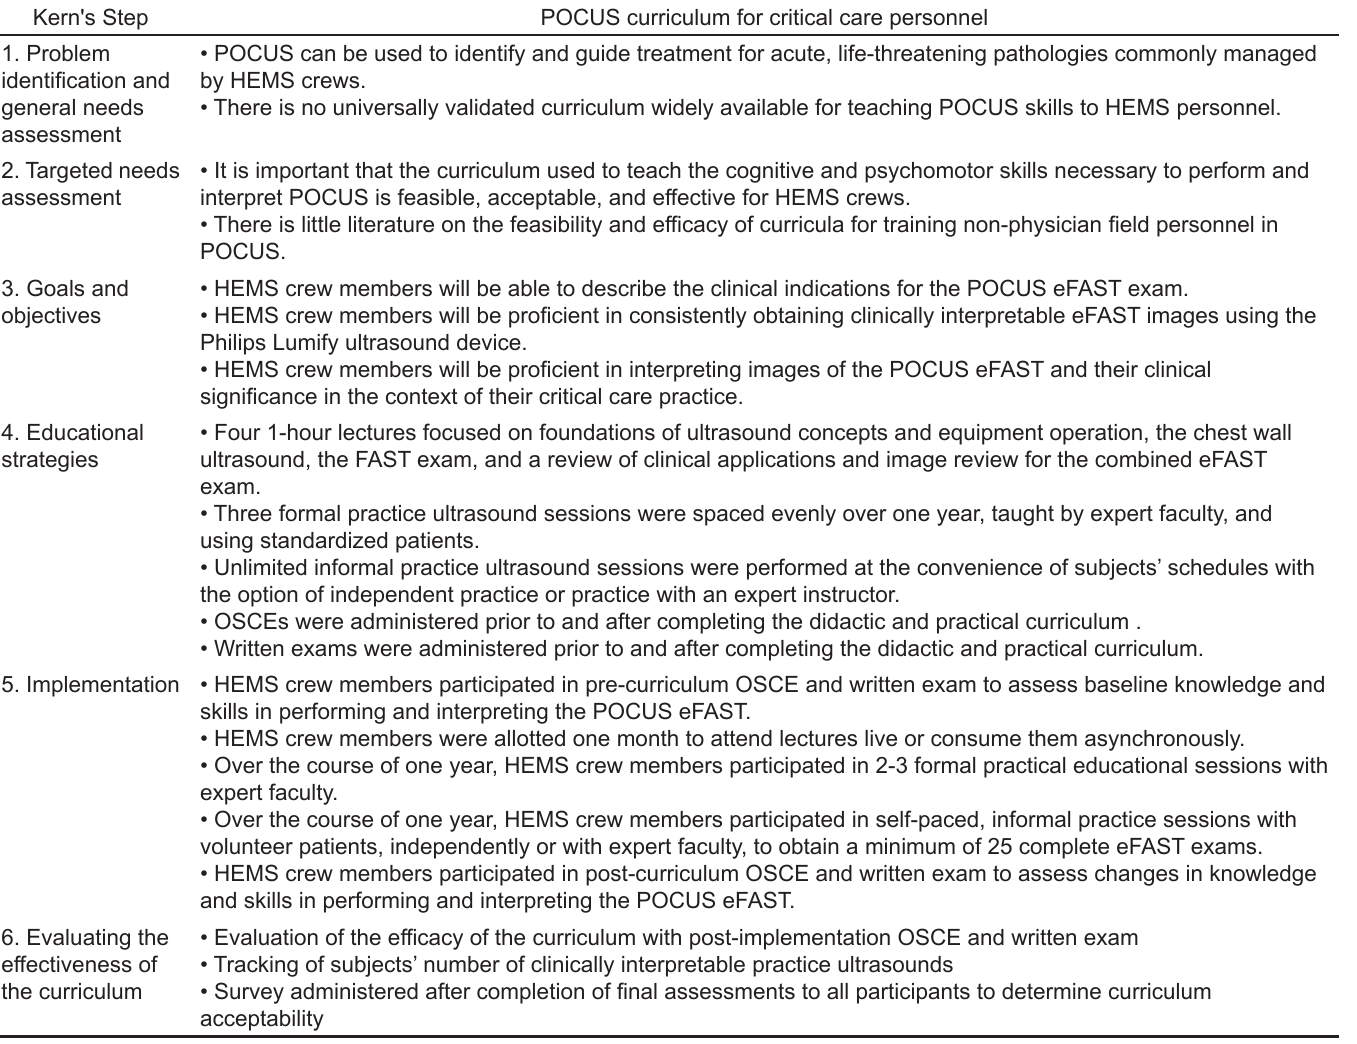
Table 1. Kern’s six-step framework for curriculum